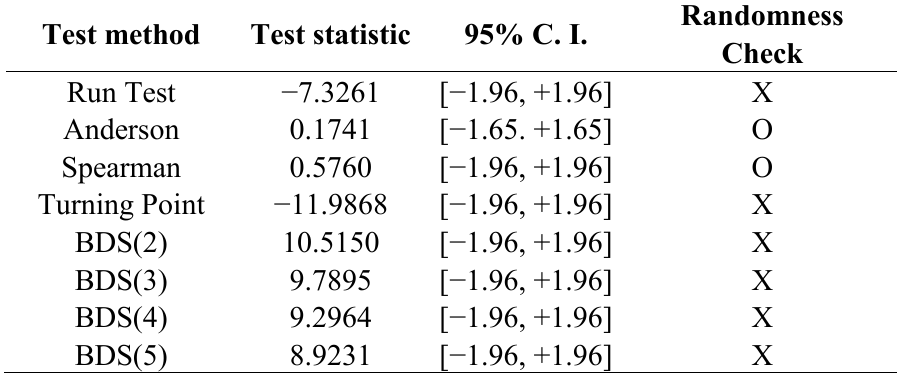
Table 1. Test statistics of malaria time series